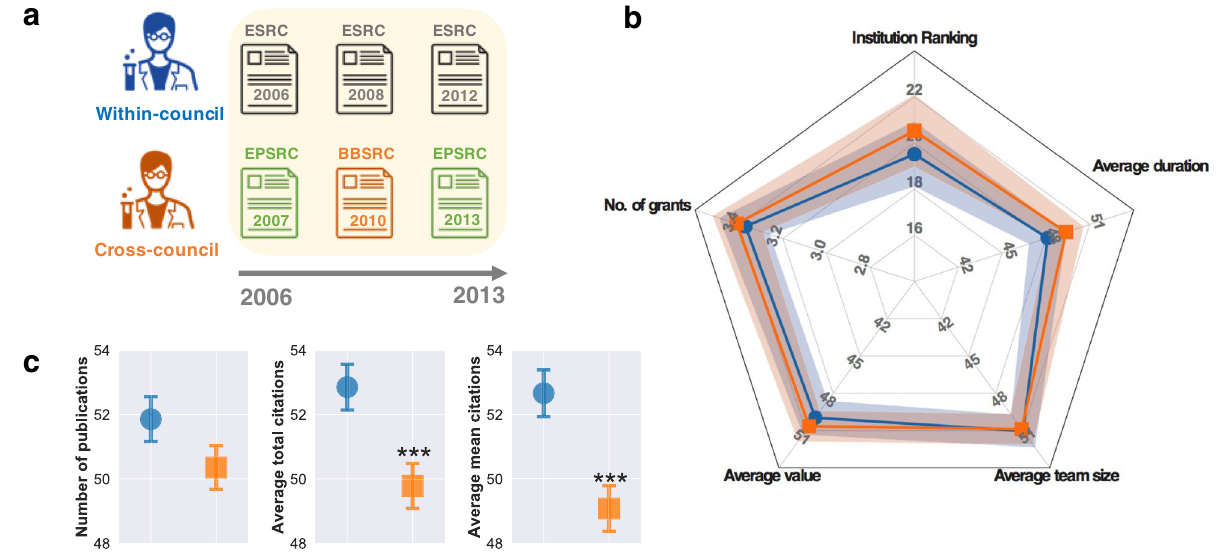
Fig. 3 Comparing scienti fi c outcomes between cross-council and within-council investigators. a An illustrative example of cross-council (orange) and within-council (blue) principal investigators (PIs). Both PIs obtained 3 research grants during the observation window from 2006 to 2013, but the